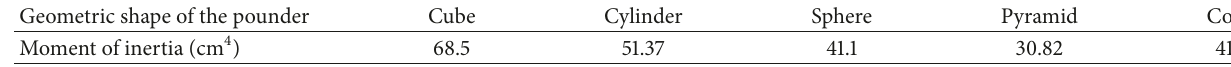
Table 2: Moment of inertia of pounders with different geometric shapes.